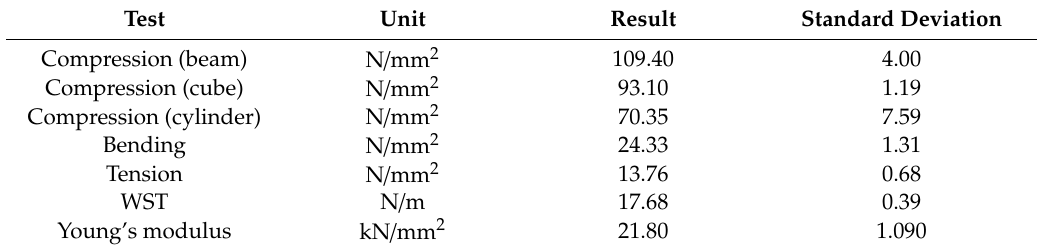
Table 4. Material characterization